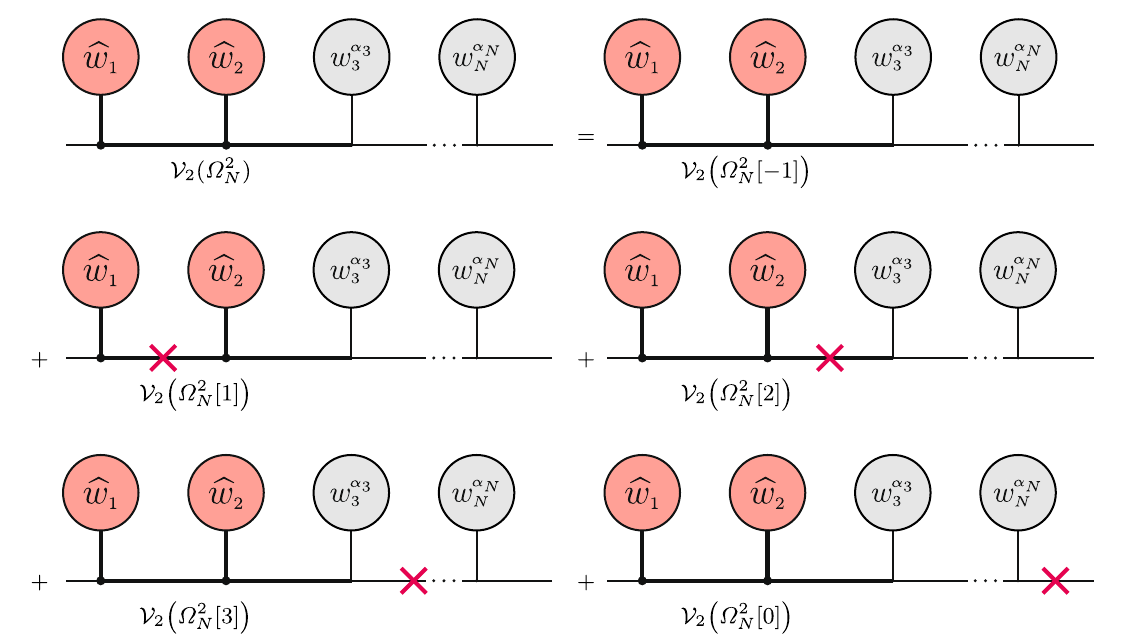
[ j ] ) terms with j = 0 ,..., 3. N